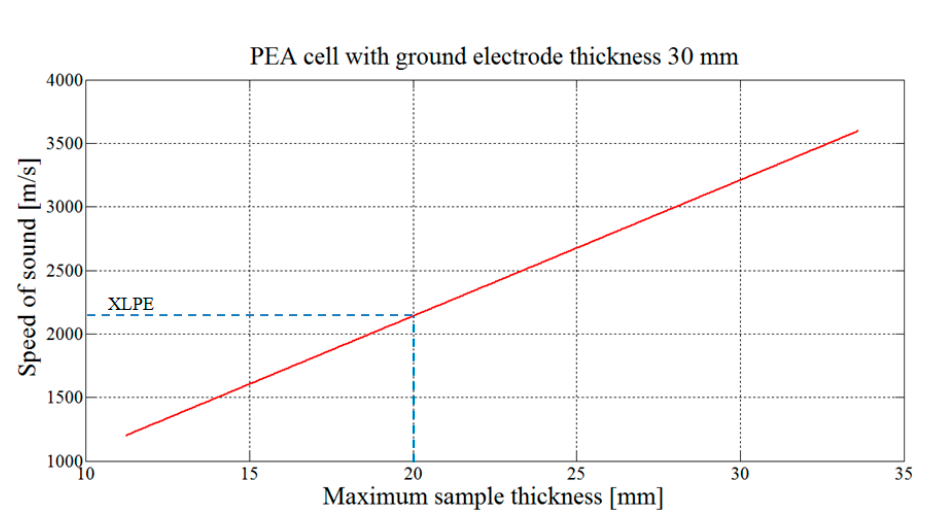
Figure 9. Abacus for the choice of the minimum ground electrode thickness needed to avoid reflections in the main output signal. The red dotted line highlights our case in which the dielectric layer made of XLPE material have sound velocity of 2200 m/s and thickness 20 mm. To verify the above-mentioned, a simulation has been made by changing the thickness of the ground electrode from 30 (see Figure 6) to 34 mm. As it can be seen from Figure 10, which is the output of the PEA cell model, the reflected wave 𝑝 (cid:2879)(cid:3019) (𝑡) is detected by the sensor at almost 16 μ s, while the positive peak 𝑝 (cid:2878) (𝑡) at a time equal to 14.6 μ s.